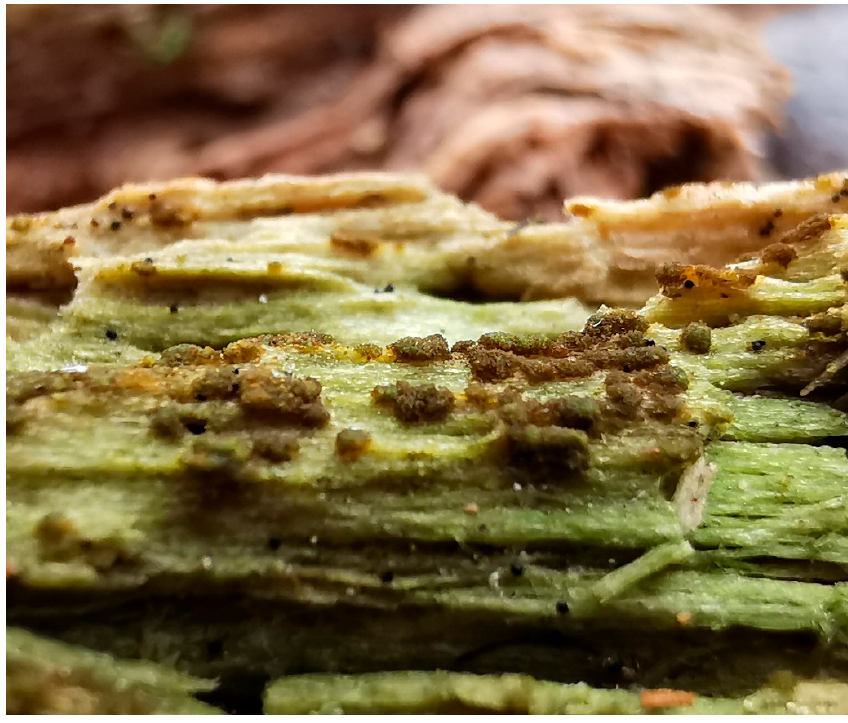
Figure 4. Gametophytic stage of Buxbaumia viridis growing on wood-fibers.